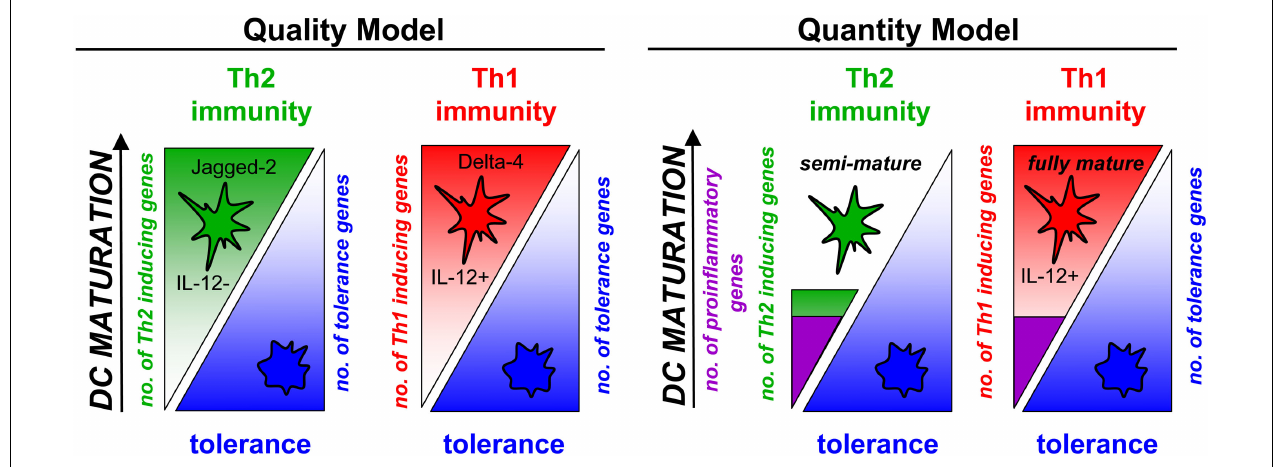
FIGURE 1 | Semi-maturation as a quantitative level of gene regulation in DC maturation. DC maturation and the subsequent induction of polarizedTh1 orTh2 responses has been considered mostly as a consequence of qualitative differing maturation pathways, meaning the microbial direction of eitherTh1- orTh2-inducing genes in DCs with simultaneous down-regulation of tolerance genes (Quality Model). Indeed, the Notch ligands Jagged-2 and Delta-4 characterize the different